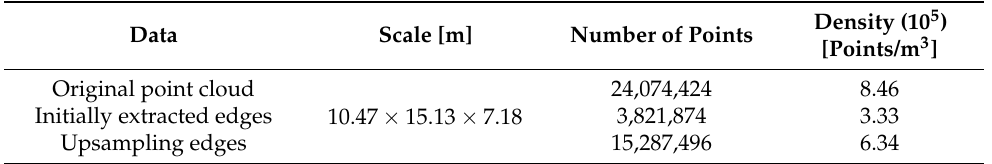
Table 3. The number of points and density of the Nakajima residence data.